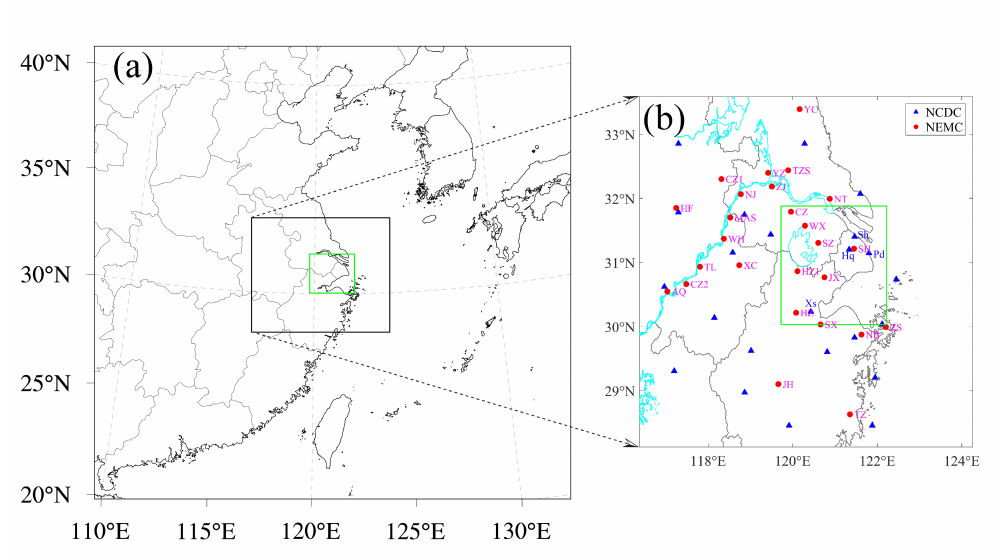
Figure 1. (a) Three nested WRF-Chem domains. (b) The locations of cities (red dots) and weather stations (blue triangles) in the YRD. The green rectangular regions represent the innermost domain and also the central YRD region. The cities in (b) include the megacity Shanghai (SH); Hangzhou (HZ), Ningbo (NB), Jiaxing (JX), Huzhou (HZ1), Shaoxing (SX), Jinhua (JH), Zhoushan (ZS) and Taizhou (TZ) located in Zhejiang Province; Nanjing (NJ), Wuxi (WX), Changzhou (CZ), Suzhou (SZ), Nantong (NT), Yancheng (YC), Yangzhou (YZ), Zhenjiang (ZJ) and Taizhou Shi (TZS) located in Jiangsu Province; and Hefei (HF), Wuhu (WH), Ma’anshan (MAS), Tongling (TL), Anqing (AQ), Chuzhou (CZ1), Chizhou (CZ2) and Xuancheng (XC) located in Anhui Province.